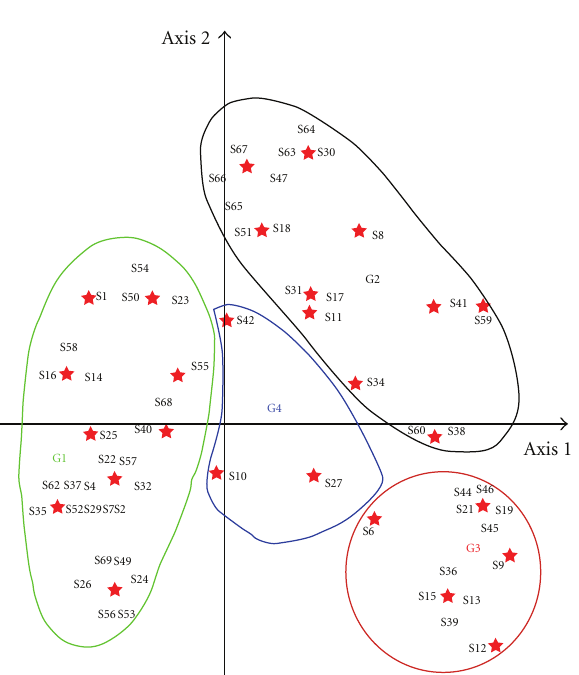
Figure 4: Principal coordinate analysis showing grouping of the species in relation to habitat and domestication levels. Species codes are those used in Table